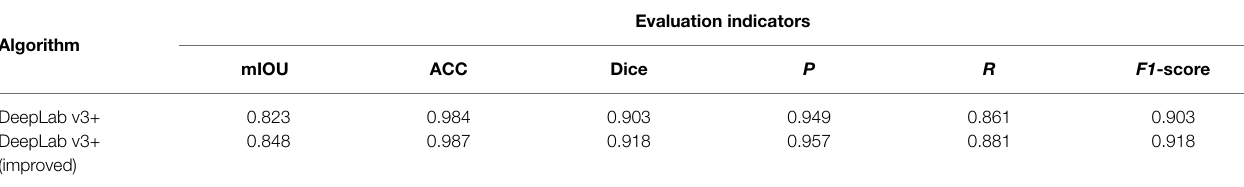
TABLE 2 | Statistics of the segmentation results of the test set TS1 by the before and after improved DeepLab v3+.